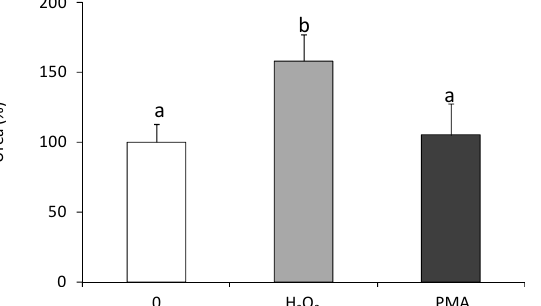
Figure 2. Effects of in vitro stimulation with hydrogen peroxide or phorbol ester on arginase activ- ity in Eisenia andrei coelomocytes. Cells were in vitro treated for 24 h with H 2 O 2 (50 µM), phorbol 12-myristate 13-acetate, PMA (0.1 µg), or with culture medium (0). Arginase activity was deter- mined as urea content and showed as % of control (arginase activity in unstimulated cells = 100%). Mean + SE, n = 6–9. Mean values that are significantly different are not assigned a common letter (e.g., a vs. b or b vs. c) according to one-way analysis of variance (ANOVA) (at p < 0.05).